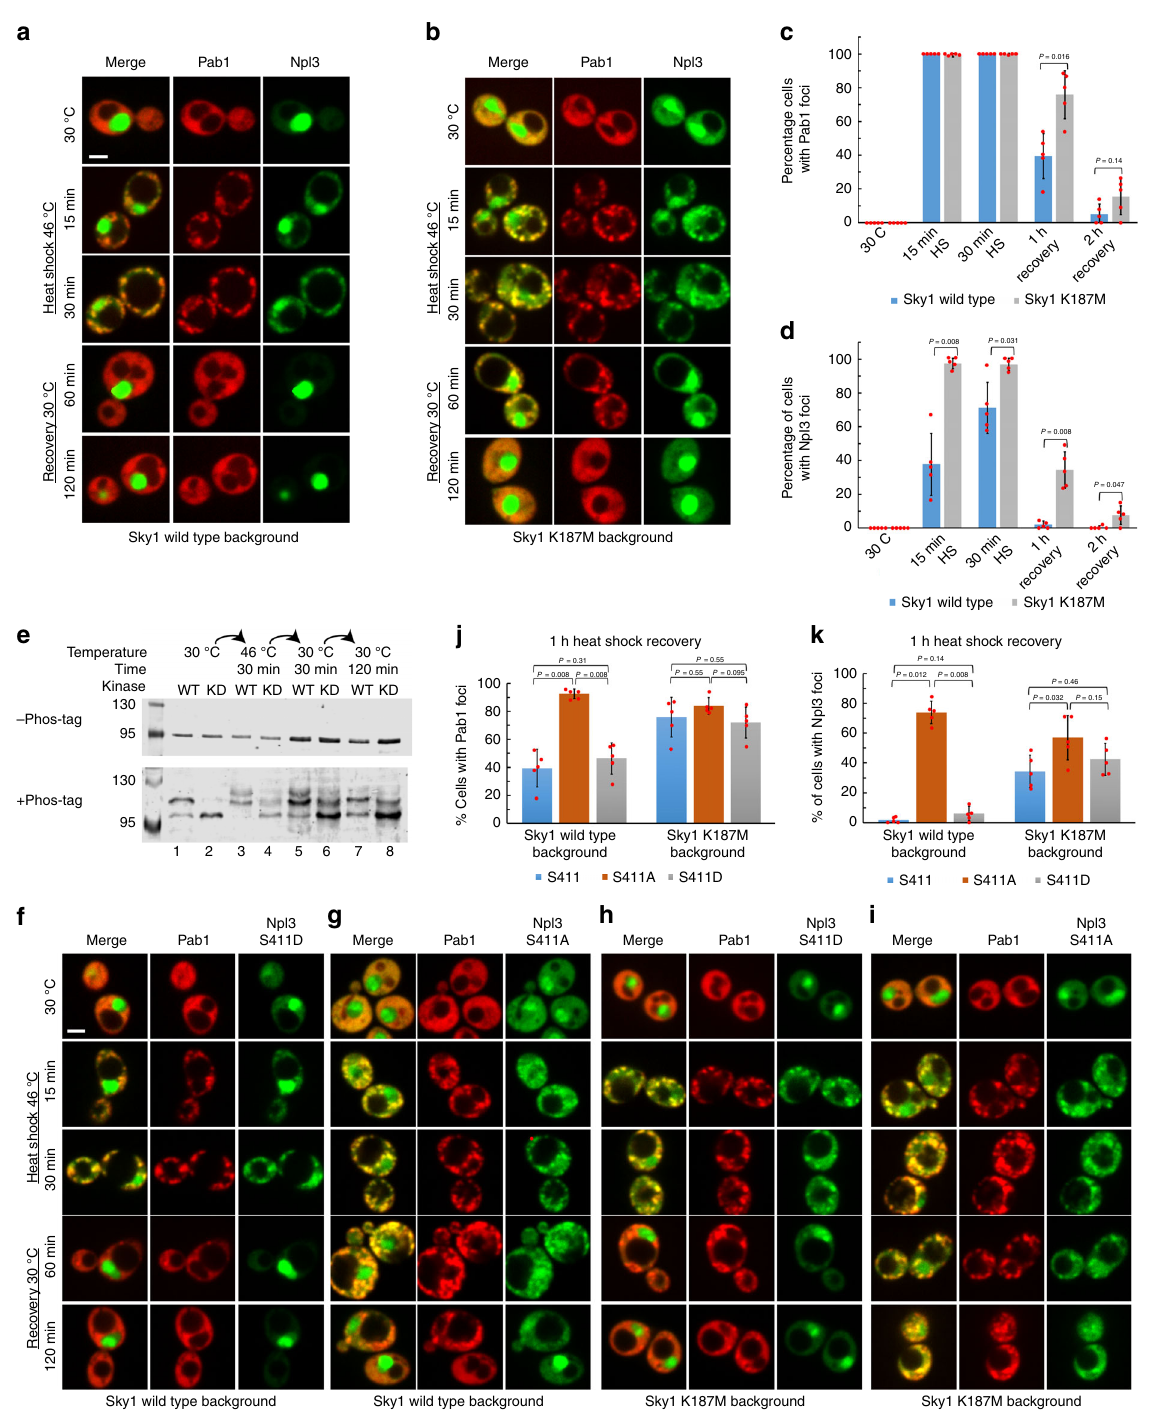
Fig. 5 Npl3 phosphorylation by Sky1 is required for ef fi cient stress granule dissolution. Fluorescence microscopy during heat shock and recovery of yeast expressing Pab1-mCherry, Npl3-GFP, and either wild-type Sky1 ( a ) or Sky1 K187M ( b ), each from its corresponding endogenous locus. Scale bar, 2 μ m. Quanti fi cation of the percentage of cells containing Pab1 foci ( c ) or Npl3 foci ( d ) in wild-type SKY1 (blue) or sky1 K187M (gray) cells. Data represent means ± SD of n = 5 independent replicates. A two-sided Mann – Whitney U test was used to calculate P values. e Yeast expressing Npl3-mCherry-His 8 and either wild-type Sky1 (WT, odd lanes) or Sky1 K187M (Kinase Dead (KD), even lanes) from the corresponding endogenous loci were grown to mid-log phase in YPD, and subjected to a heat shock and recovery. Cells were analyzed by western blotting with an anti-His 6 antibody, with and without the addition of Phos-tag. Fluorescence microscopy during heat shock and recovery of yeast expressing Pab1-mCherry; either Npl3 S411D -GFP ( f , h ) or Npl3 S411A -GFP ( g , i ); and either wild-type Sky1 ( f , g ) or Sky1 K187M ( h, i ) from the corresponding endogenous loci. Scale bar, 2 μ m. Quanti fi cation of the percentage of cells containing Pab1 foci ( j ) or Npl3 foci ( k ) for cells from a , b , and f – i expressing wild-type Npl3 (blue), Npl3 S411A (orange) , or NPL3 S411D (gray). Data represent means ± SD of n = 5 independent replicates. A two-sided Mann – Whitney U test was used to calculate P values. Source data are provided as a Source Data fi